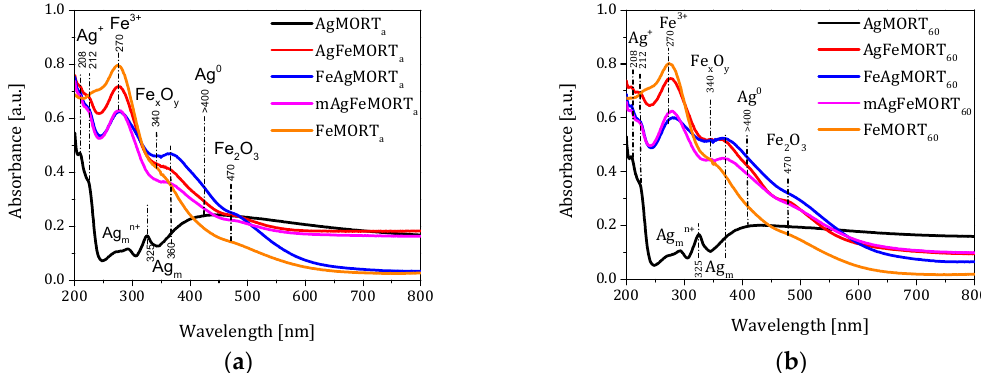
Figure 1. UV–Vis spectra of mono- and bimetallic samples prepared at: ( a ) room temperature, and ( b ) 60 °C.